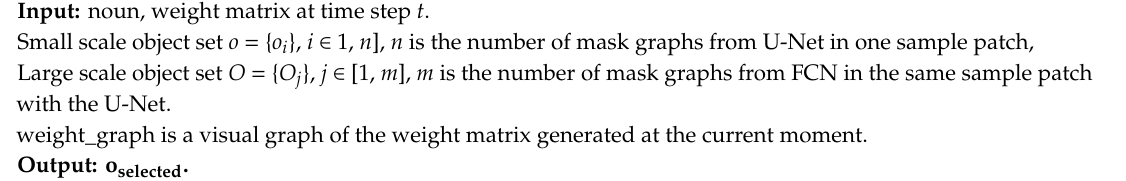
Algorithm 1. For Multi-Scale Remote Sensing Objects Recognition and Correction